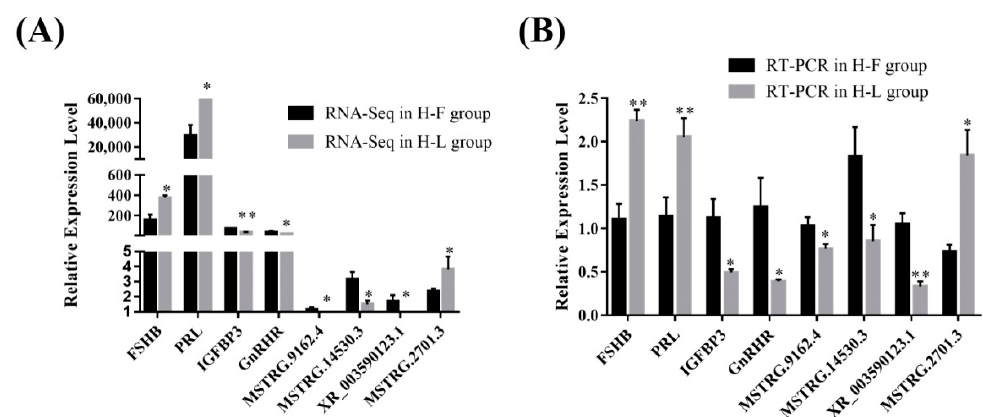
Figure 4. The verification of expression level of DE lncRNAs and DE mRNAs in different groups. ( A ) The relative expression level of four DE mRNAs and lncRNAs in different groups determined by RNA-Seq. ( B ) The relative expression level of four DE mRNAs and lncRNAs in different groups determined by RT-PCR (* p < 0.05 ; ∗∗ p < 0.01 ).